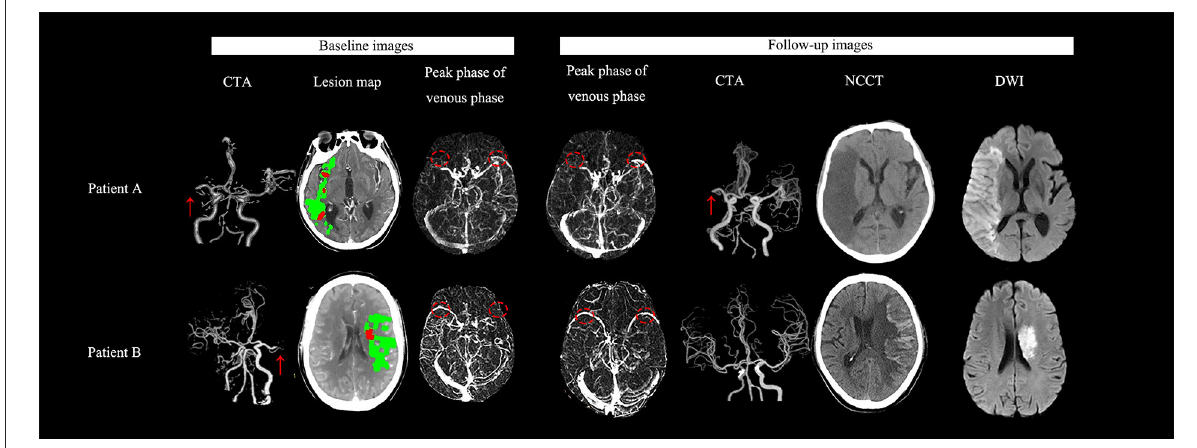
FIGURE2 Examples for illustrating the association between the stroke outcome and the dynamic change of SMCV filling. (Patient A) A 63-year-old man with right cerebral middle artery (R-MCA) occlusion (red arrow) presented with 7-ml baseline ischemic core volume (red color area on the lesion map) and ipsilateral delayed SMCV (red circle) on auto-reconstructed four-dimensional computed tomographic angiography (4D-CTA) using MIStar software. He received thrombectomy after onset. On follow-up 4D-CTA, delayed SMCV was still presented. We did not find hemorrhagic transformation (HT) on his follow-up NCCT scans. His final infarct volume (FIV) was 161ml. His National Institutes of Health Stroke Scale (NIHSS) score was 21 and modified Rankin scale (mRS) score at discharge and 3 months were 5 and 4 respectively. (Patient B) A 65-year-old man with acute left middle cerebral artery (L-MCA) occlusion (red arrow) presented with 3-ml baseline ischemic core volume (red color area on the lesion map) and ipsilateral delayed SMCV (red circle) on 4D-CTA. He did not receive any reperfusion therapy but achieved a spontaneous recanalization. On follow-up 4D-CTA, delayed SMCV reversed to be bilaterally symmetric. On 24h NCCT after admission, we did not find HT. His FIV was 27ml. His NIHSS score was 24, and the mRS score at discharge and 3 months were 4 and 4